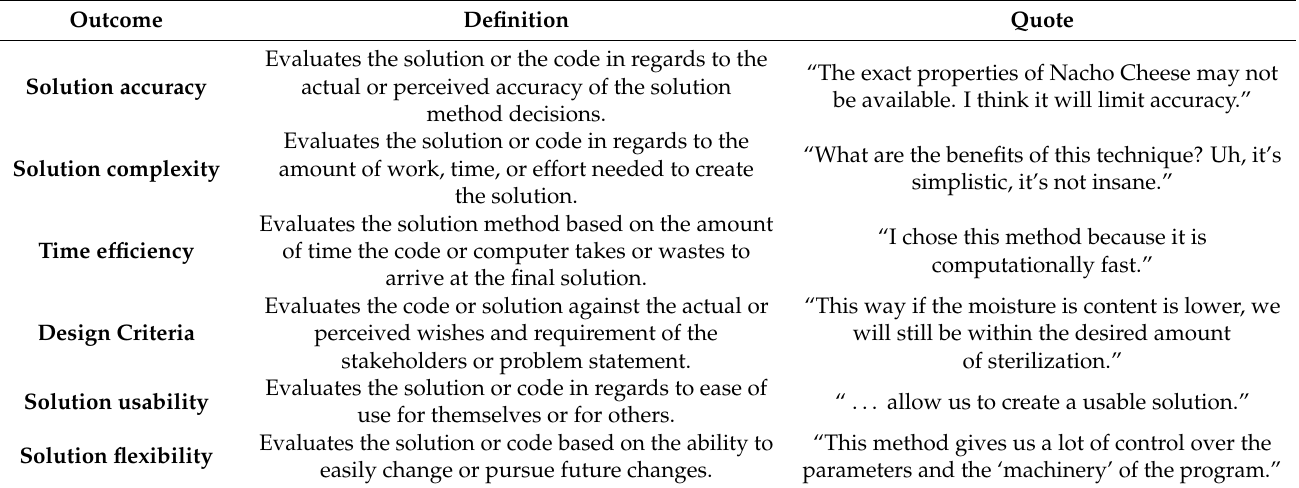
Table 6. Definitions and quotes of CT outcomes identified for evaluation (letters denote individual deidentified students).